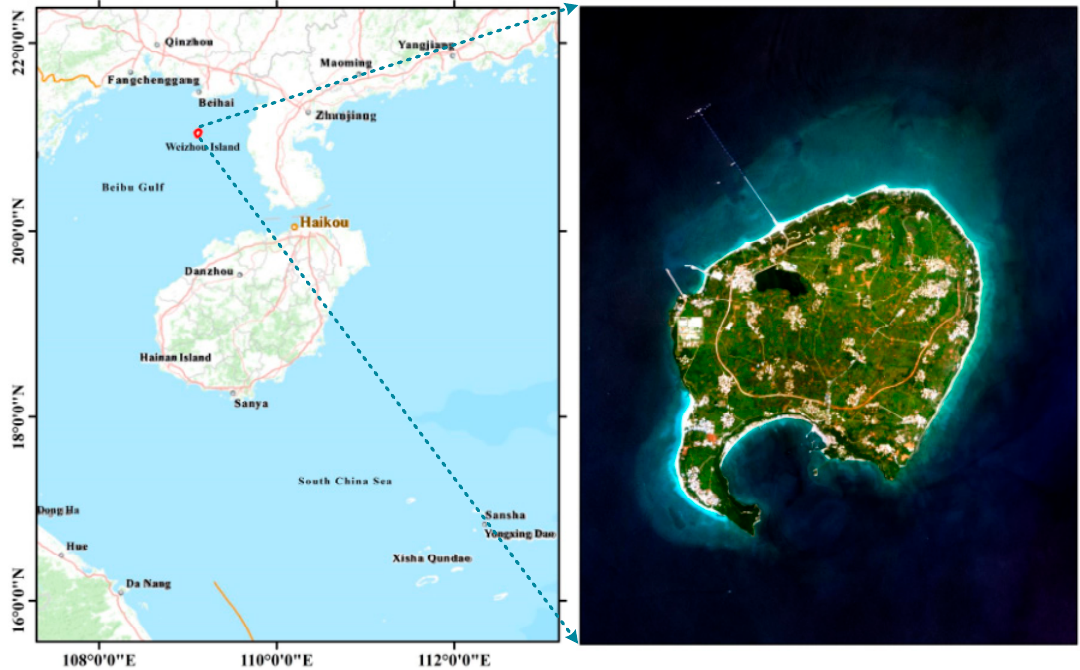
Figure 1. The position of Weizhou Island and one of the corresponding satellite image (ZY-3).